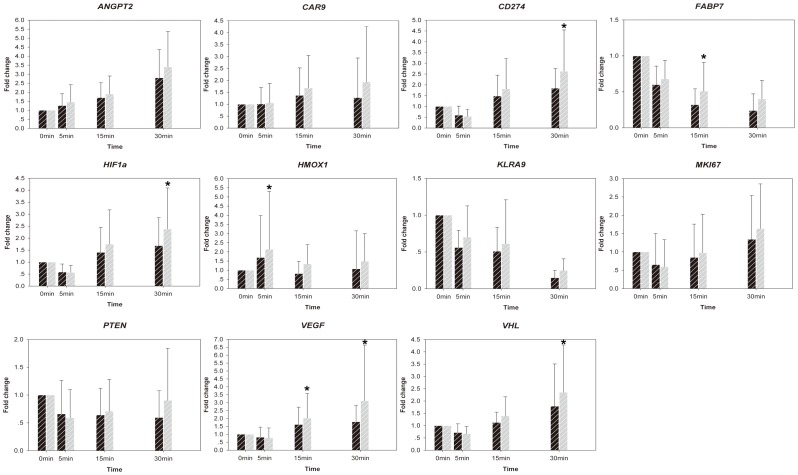
Mean relative expression levels of 11 target genes based on normalizations with GAPDH (brown) or the combination of B2M, ACTB and PPIA (black).Normalization with GAPDH lead to increased relative expression levels for most of the target genes at the time points 5 min, 15 min, and 30 min comparing with the 0-time point. (N = 10 at each time point) Whiskers illustrate the standard deviation of Cp values. Fold change >2 or <0.5 was considered significant. *: Significant differences were found between the two normalization methods.